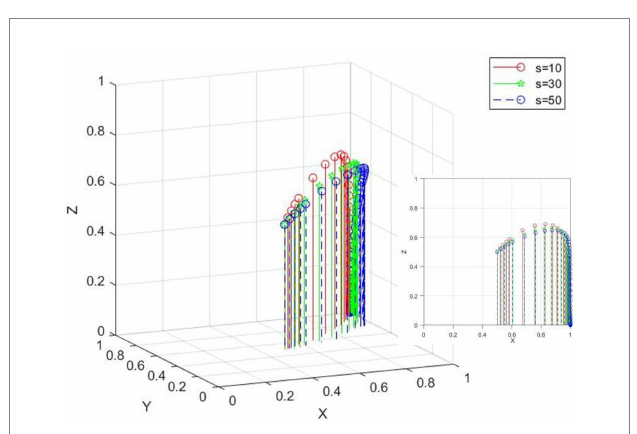
FIGURE 5 Impact map of government subsidies (Scenario 1).